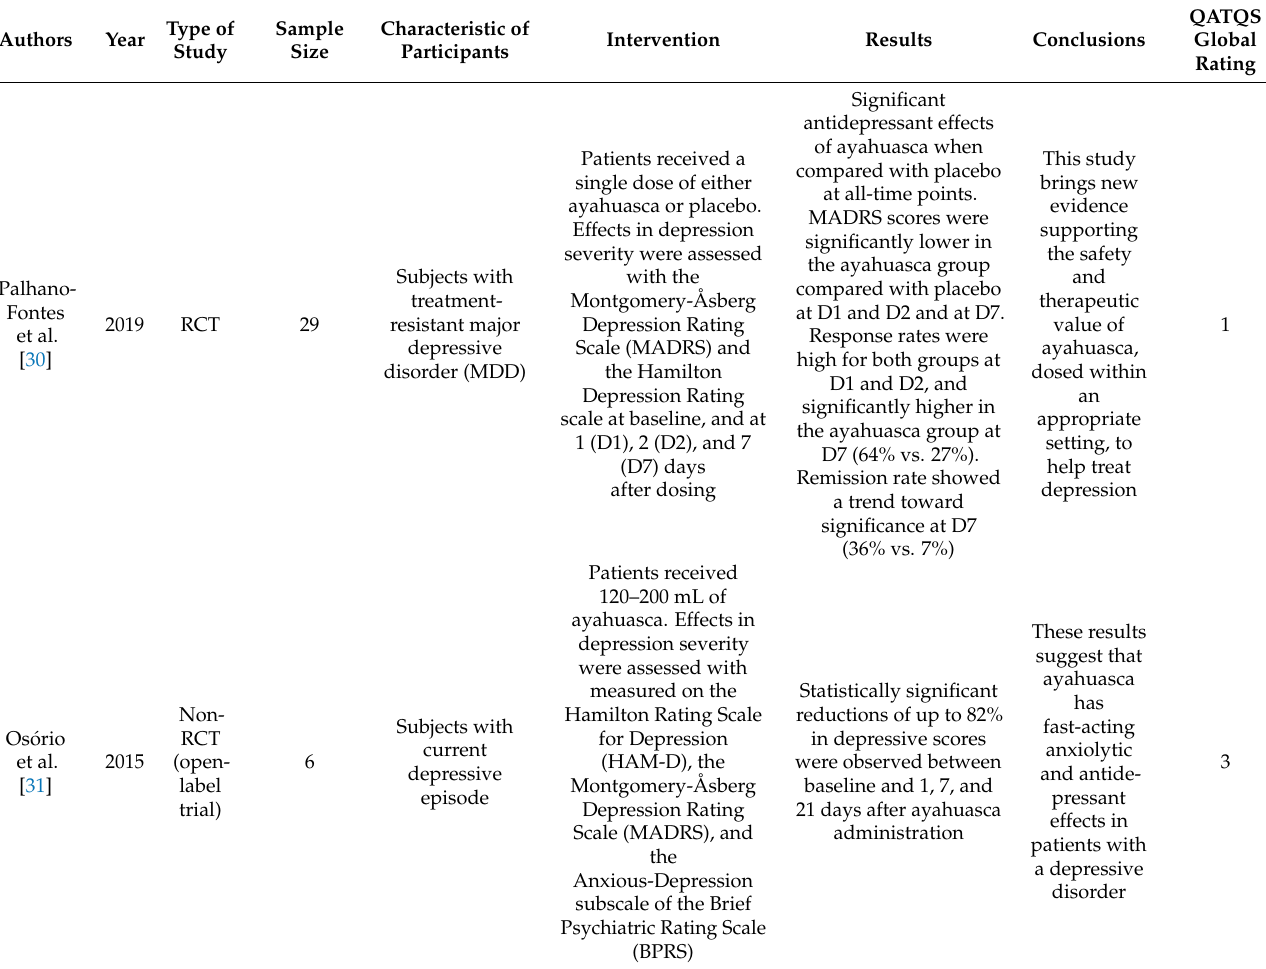
Table 2. Summary of clinical studies evaluating the antidepressant effect of DMT ( n = 4). The abbreviations are explained in the